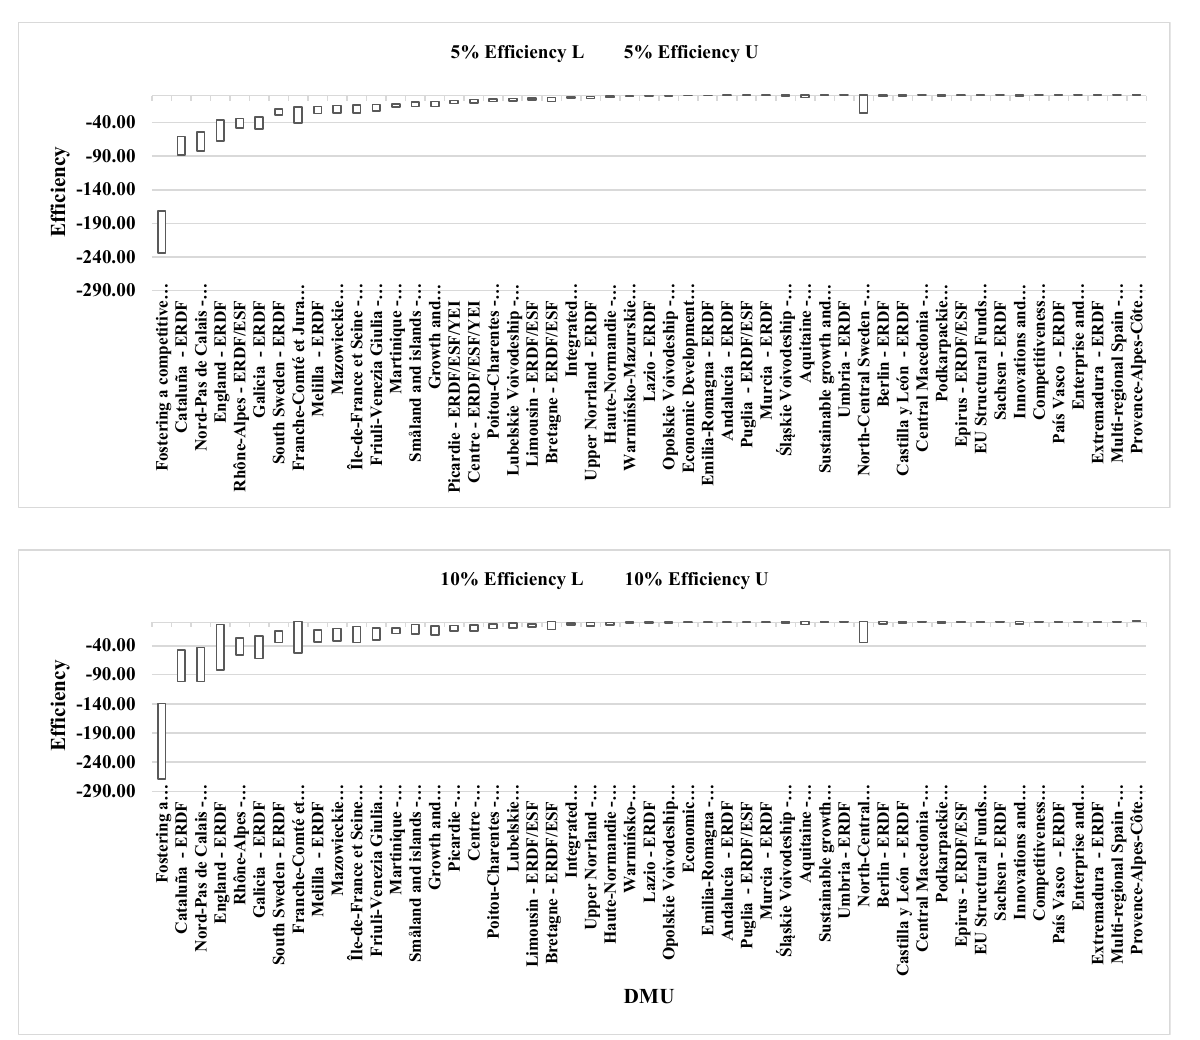
Figure 6. Results of robustness analysis per OP .